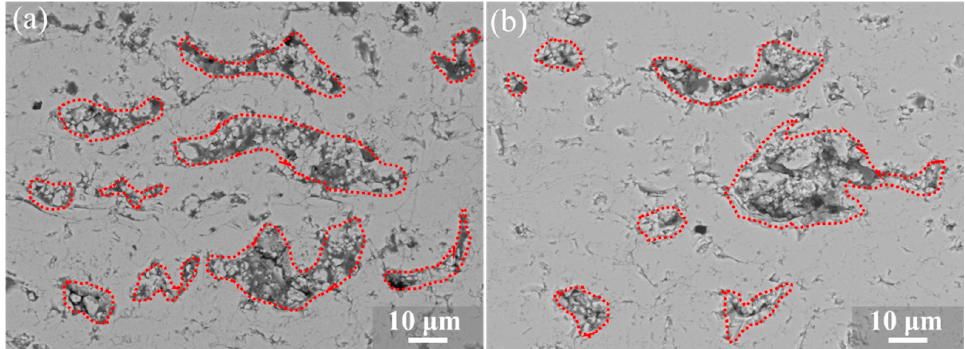
Figure 8. Schematic diagrams show the method used for measuring the proportion of particles embedded in the matrix coating: ( a ) as-sprayed EMAP TBC, and ( b ) EMAP TBC after sintering at 1300 °C for 40 h.